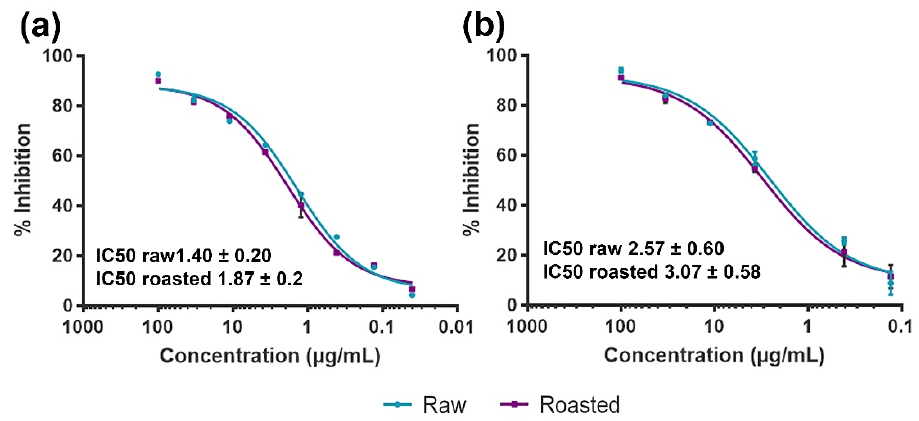
Figure 4. IgE binding from the pool of patient sera to peanut extracts (PEs) in ELISA. ( a ) Inhibition of peanut-allergic patient IgE binding to raw PE (base-coat) by raw PE (turquoise line) and roasted PE (purple line). ( b ) Inhibition of peanut-allergic patient IgE binding to roasted PE (base-coat) by raw PE (turquoise line) and roasted PE (purple line).